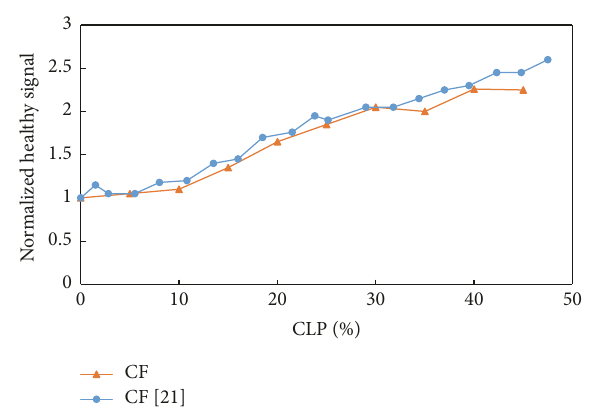
Figure 26: Comparison between the crest factor values of this study and [21], normalized to the healthy value applied to the residual signal.